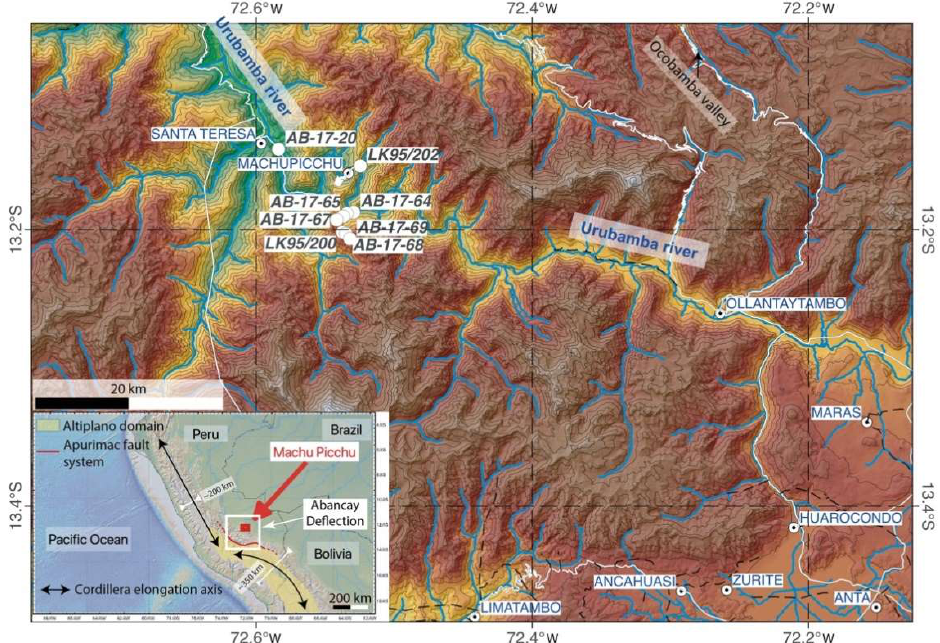
Figure 1. Location of the thermochronologic data (white dots) close to the Machu Picchu archaeo- logical site in the Urubamba valley (Peru). The inset shows the location of the main map in Peru.